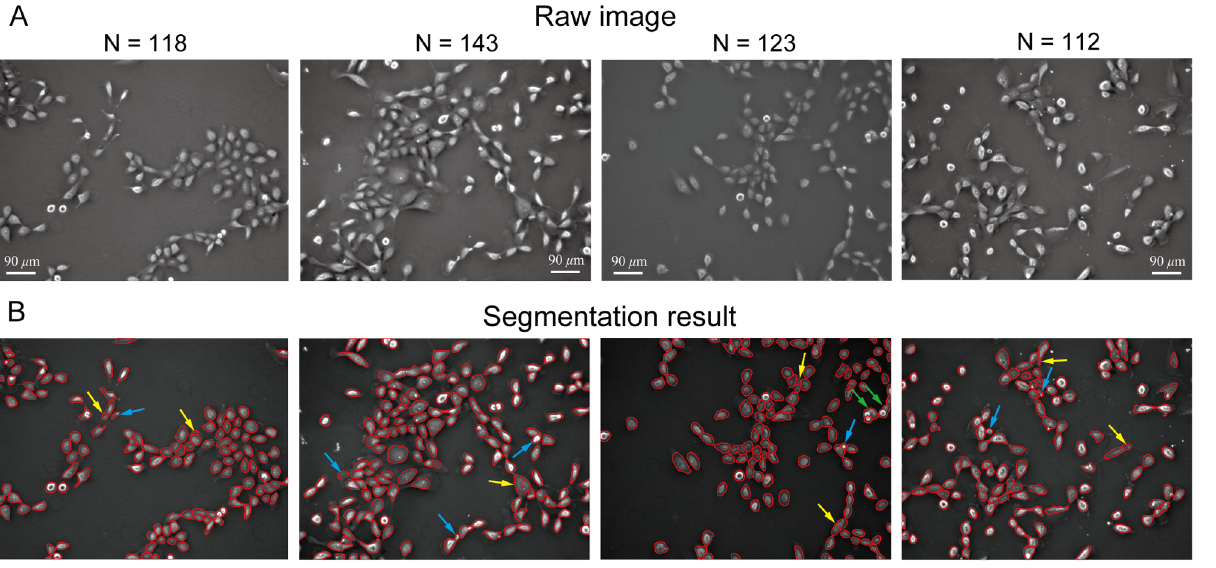
Fig 12. Cell image segmentation result for phase contrast images from four different experiments. (A) Raw negative phase contrast images. (B) Segmentation result with false segmented cells pointed by